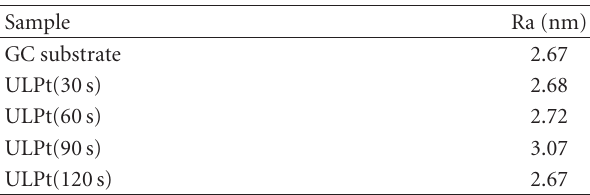
Table 1: The surface roughness (Ra) of GC substrate and ULPt electrodes, which was calculated from AFM data, when the scanning area was 3 μ m × 3 μ